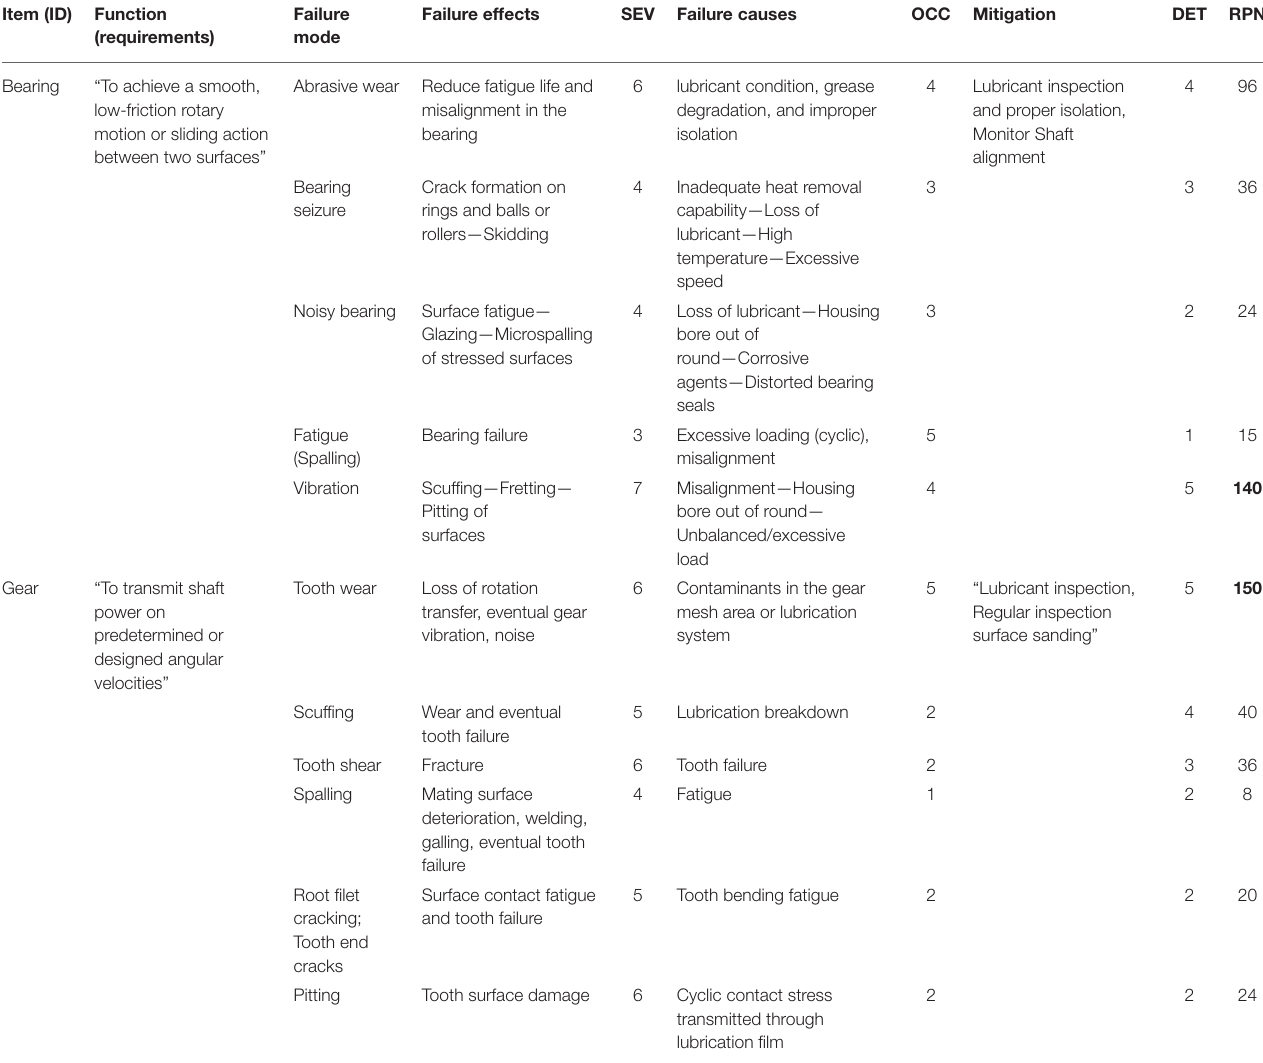
TABLE 6 | FMEA of test rig. Item (ID) Function